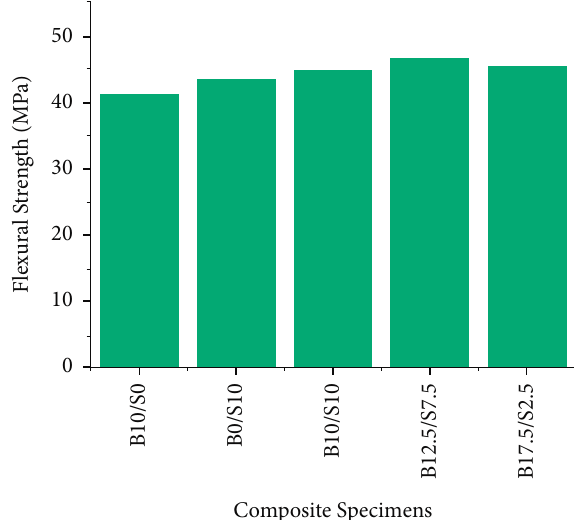
Figure 7: Flexural strength of the composite specimens.